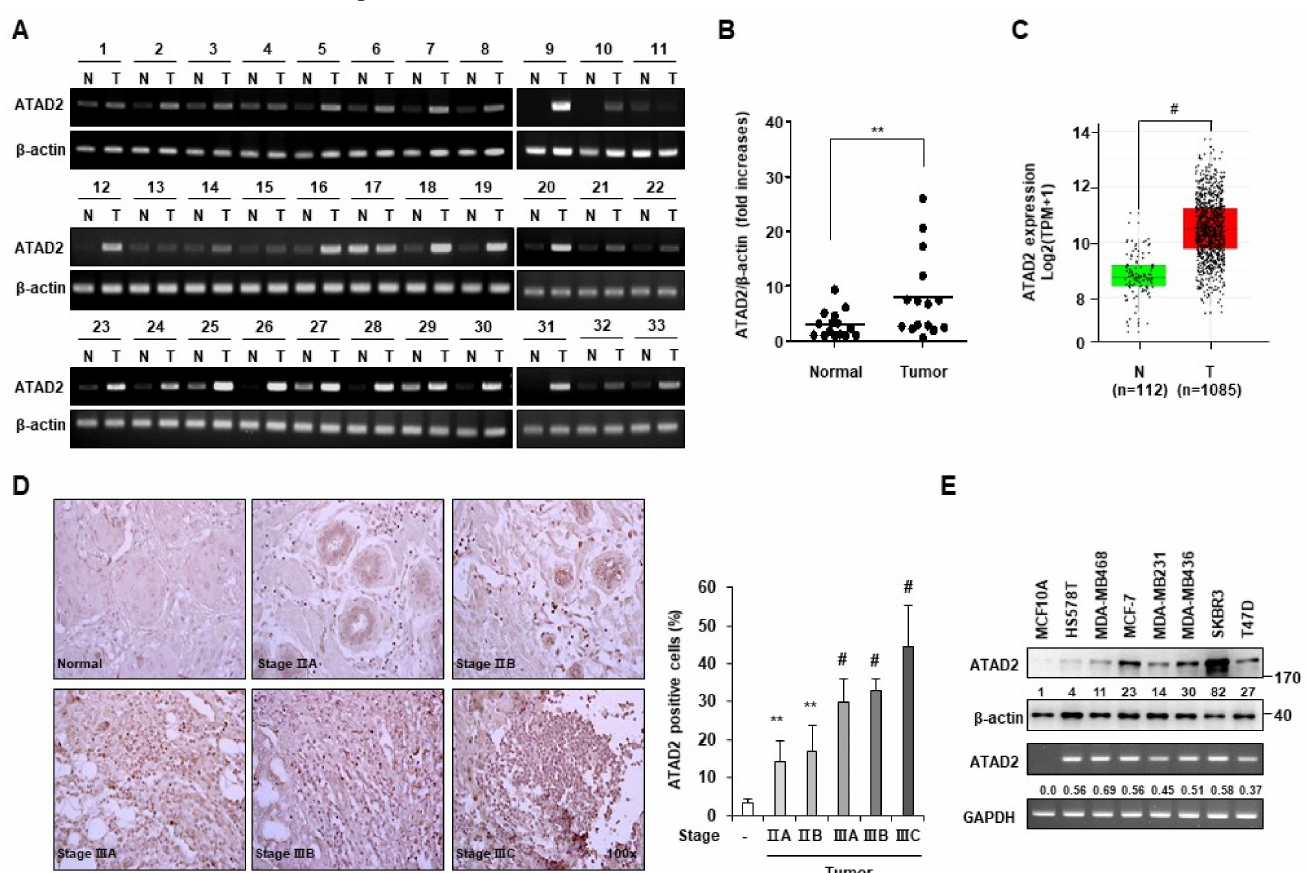
Figure 1. The expression of ATAD2 is elevated in breast cancer tissues and cell lines. ( A ) RT-PCR was performed to analyze the mRNA expression of ATAD2 in 33 paired samples of the non-tumor breast (N) and tumor breast (T) tissues. β -actin was used as an internal control ( B ) The relative expression level of ATAD2 mRNA was identified by qRT-PCR analysis in 15 paired samples of the non-tumor breast (N) and tumor breast (T) tissues. ( C ) ATAD2 expression in TCGA cohort using the GEPIA (http://gepia.cancer-pku.cn/detail.php, accessed on 5 September 2017). ( D ) ATAD2 expression in normal breast ( n = 10) and breast cancer tissues including stage IIA ( n = 12), stage IIB ( n = 8), stage IIIA ( n = 12), stage IIIB ( n = 4), and stage IIIC ( n = 14). Original magnification, 100 × . The histogram shows the relative intensity of ATAD2-positive cells. The mean values and the standard error were obtained from two individual experiments. ** p < 0.01, # p < 0.001. ( E ) The level of ATAD2 protein and mRNA in human breast cancer cell lines was verified via Western blot and RT-PCR analysis, respectively. Relative intensities were measured by ImageJ. Uncropped blots can be found in Figure